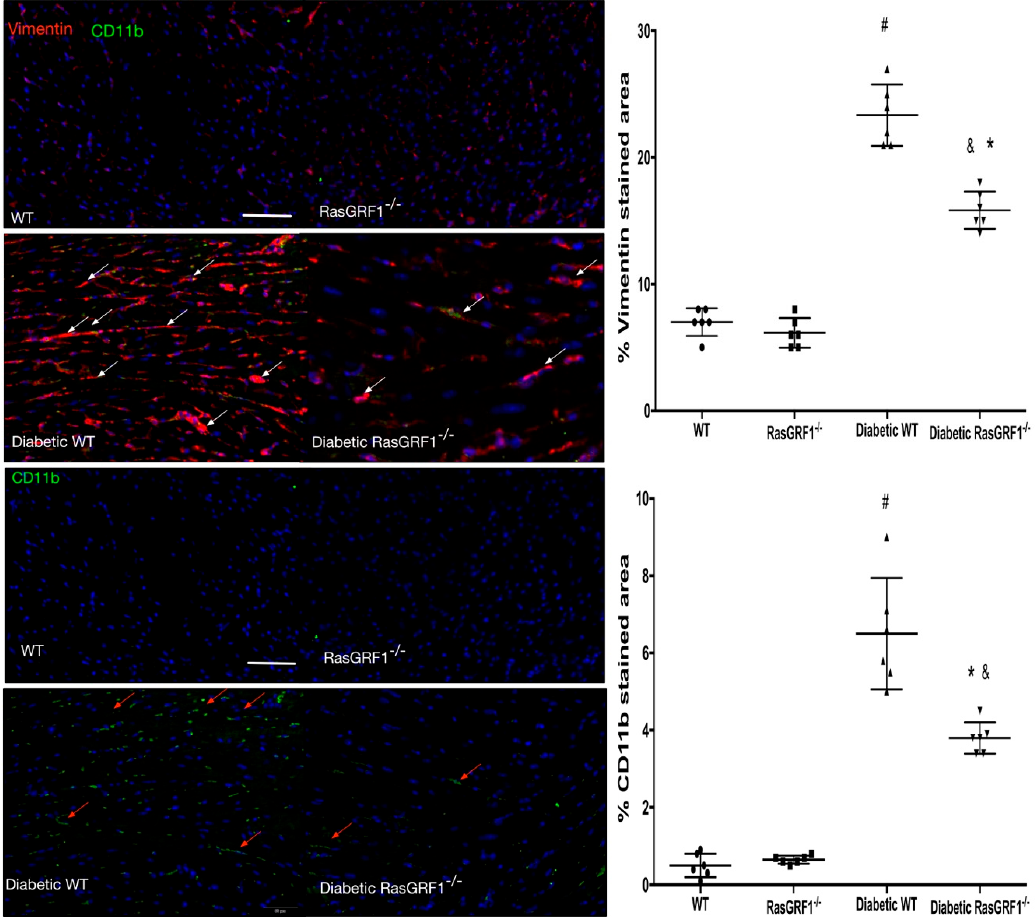
Figure 4. Effects of RasGRF1 knockout on the expression of CD11b and Vimentin in diabetic mice. Tissue sections were stained with double immunofluorescence staining for vimentin (red) and CD11b (green) expressing cells. Sham control mice (all n = 4 in WT and RasGRF1 − / − mice; no difference between these two groups was observed); Diabetic WT and diabetic RasGRF1 − / − mice (all n = 4 in each group); the white arrow indicated a vimentin-positive area, and the red arrow indicated the CD11b positive cells. In contrast to diabetic WT mice, diabetic RasGRF1 − / − mice in an attenuated chronic diabetic condition induced monocytes infiltration and vimentin deposition. # indicate p < 0.01 vs. normal WT and normal RasGRF1 − / − mice; * p < 0.05 vs. diabetic WT mice. & p < 0.05 vs. normal WT and normal RasGRF1 − / − mice. Scale bar = 200 μ m.